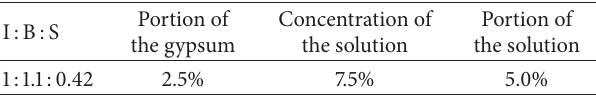
Table 2: Proportion of the analogical material.